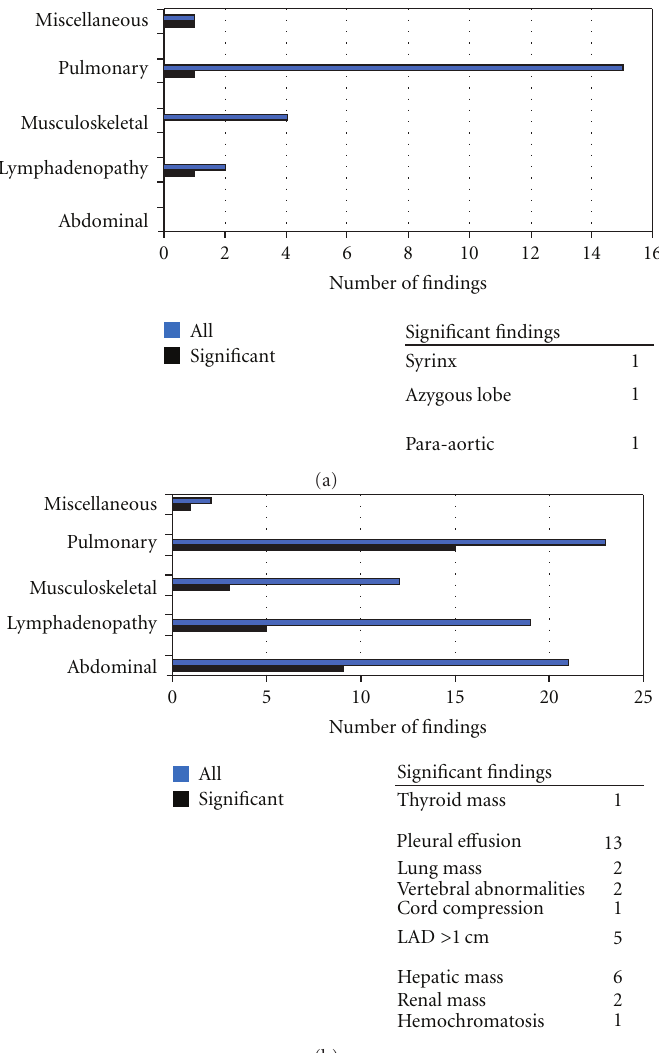
Figure 1: Organ involvement of noncardiac findings in the pediatric and adults cohorts.